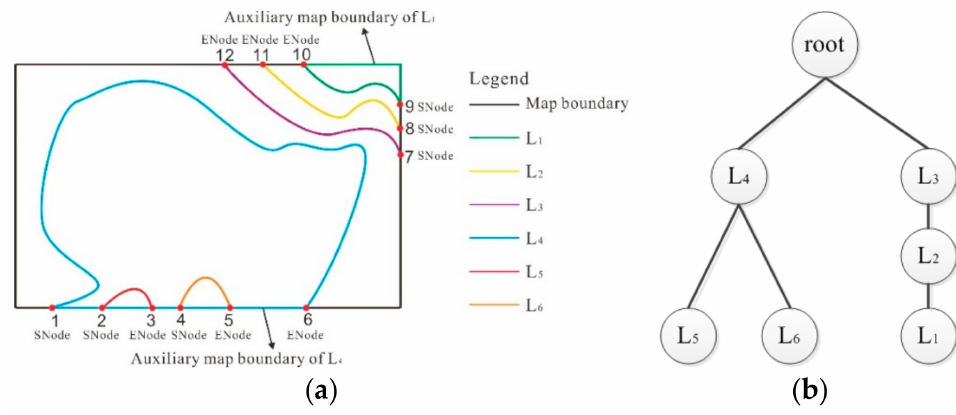
Figure 3. An adjacent relation tree of open contours: ( a ) open contour lines and ( b ) adjacent relation